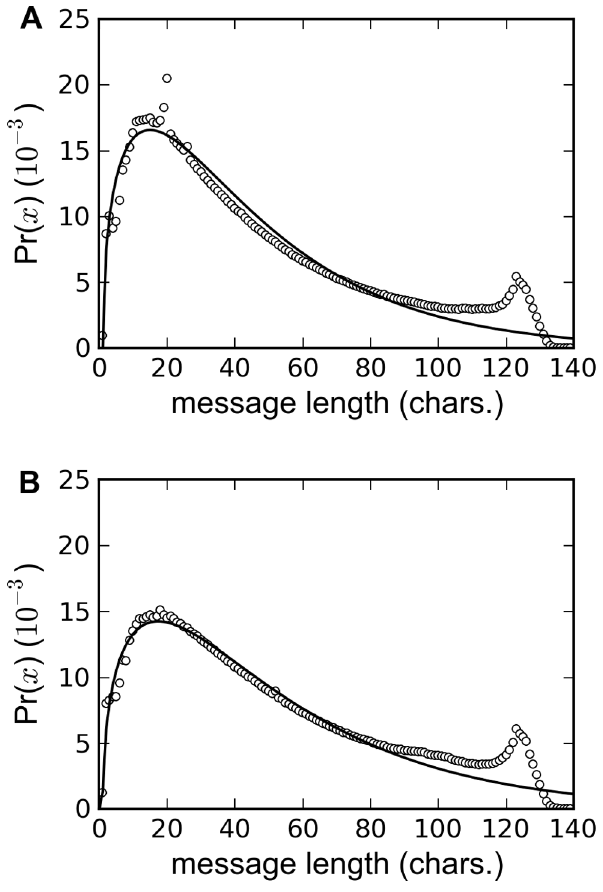
Figure 2. Representative utterance length distributions per year. Utterance length distribution of every first available Friday of December in the dataset.